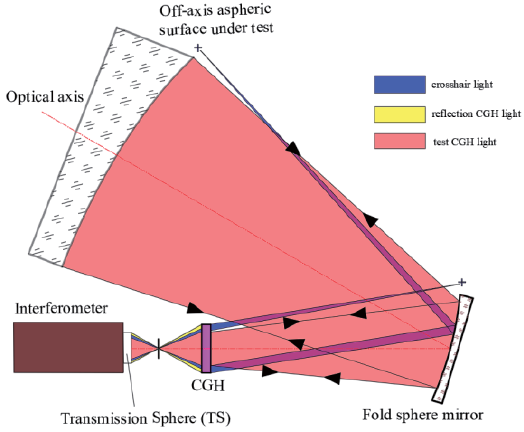
Figure 4. Schematic diagram of the hybrid compensation method for off-axis aspheric surface.